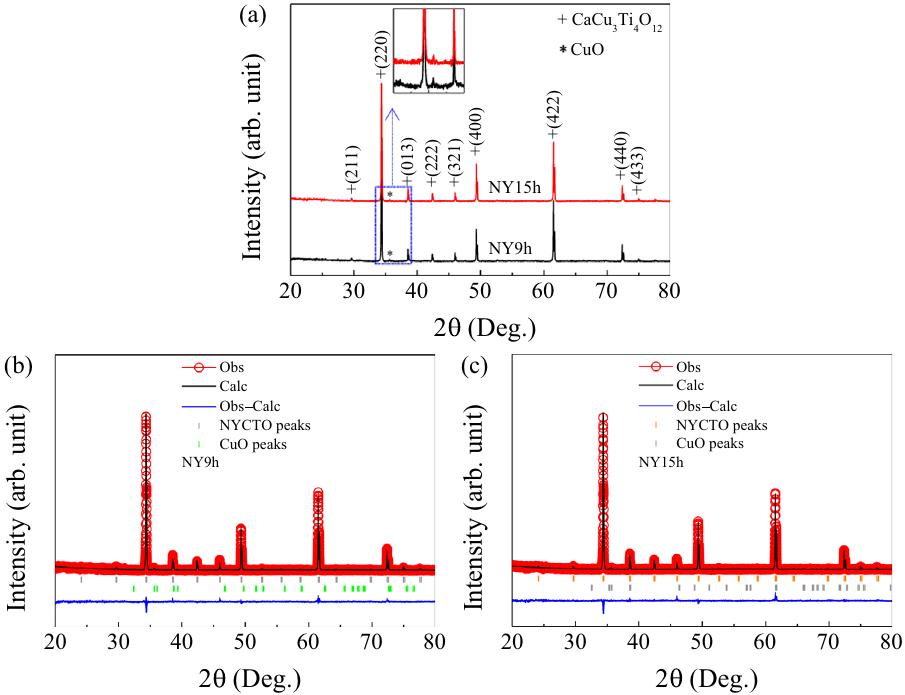
Figure 1. ( a ) XRD patterns of NY9h and NY15h ceramics. ( b , c ) respective Rietveld profile fits of these two